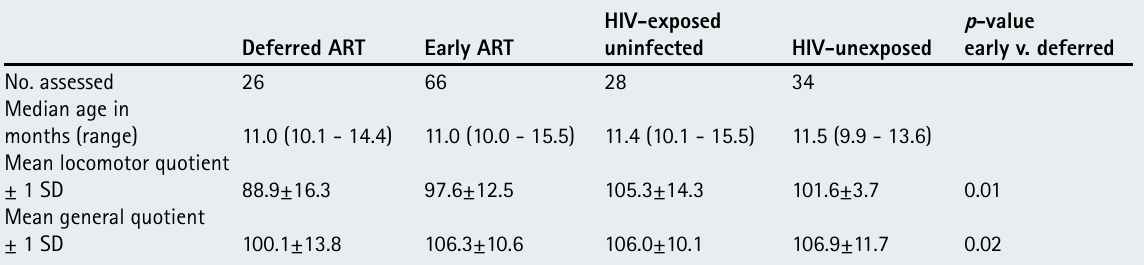
tAbLe I. MeAn qUotIentS of InfAntS for DeferreD V. eArLY HAArt AnD HIV-expoSeD UnInfecteD AnD UnexpoSeD